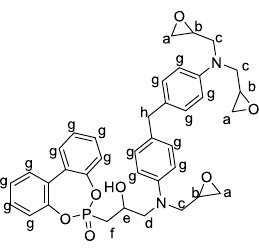
Figure 17. MBDA-BPPO structure.